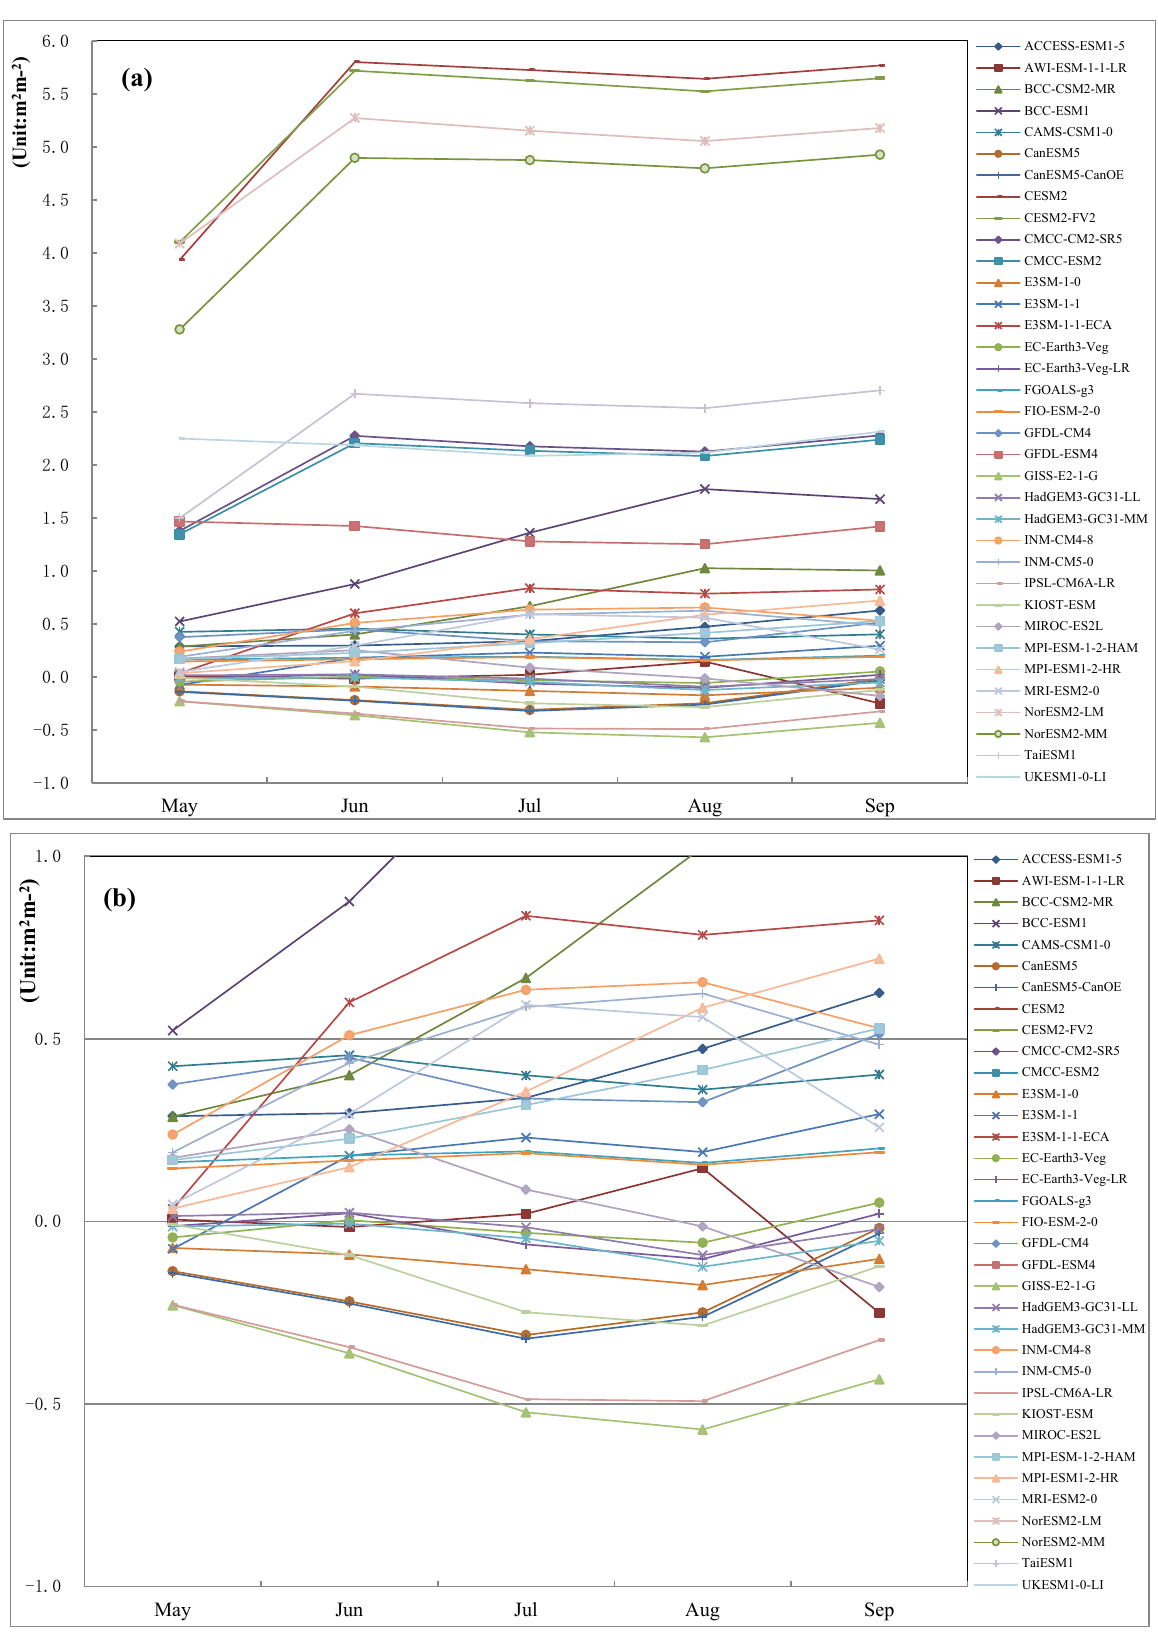
Figure 4. The bias of the monthly LAI during the growing season of the Tibetan Plateau between each CMIP6 model and the GLASS data. The y ‐ axis is from − 1 to 6 in ( a ), and from − 1 to 1 in ( b ). Moreover, the good simulations of area ‐ averaged LAI of EC ‐ Earth3 ‐ Veg, EC ‐ Earth3 ‐ Veg ‐ LR, and HadGEM3 ‐ GC31 ‐ LL were due to the positive and negative biases in different months cancelling each other out. EC ‐ Earth3 ‐ Veg and EC ‐ Earth3 ‐ Veg ‐ LR underestimated LAI in May ( − 0.04 to − 0.01 m 2 m − 2 ), July ( − 0.06 to –0.03 m 2 m − 2 ), and August ( − 0.1 to − 0.05 m 2 m − 2 ), while LAI was overestimated in June (0.003–0.022 m 2 m − 2 ) and September (0.02– 0.05 m 2 m − 2 ), HadGEM3 ‐ GC31 ‐ LL overestimated LAI in May (0.014 m 2 m − 2 ) and June (0.024 m 2 m − 2 ), but underestimated LAI in July ( − 0.016 m 2 m − 2 ), August ( − 0.09 m 2 m − 2 ), and September ( − 0.021 m 2 m − 2 ), and these biases partially canceled each other out, making the overall average bias smaller. Although the bias of LAI in May was small, the relative LAI bias was quite large in May (Figure S1). For example, the relative LAI bias of the CLM family (except for FIO ‐ ESM ‐ 2 ‐ 0) was highest in May and June (364–1105%) and then decreased from May or June to August (265–725%), which suggested that improvements at the beginning of growth are key to these models. 3.2.2. Monthly LAI Trend None of the CMIP6 models captured the monthly LAI trend well, even those models that showed good agreement for the annual LAI trend (Figure 5). The good overall greening simulations of E3SM ‐ 1 ‐ 1, INM ‐ CM5 ‐ 0, INM ‐ CM4 ‐ 8, and MPI ‐ ESM1 ‐ 2 ‐ HR were due to the overestimations and underestimations in different months cancelling each other out.